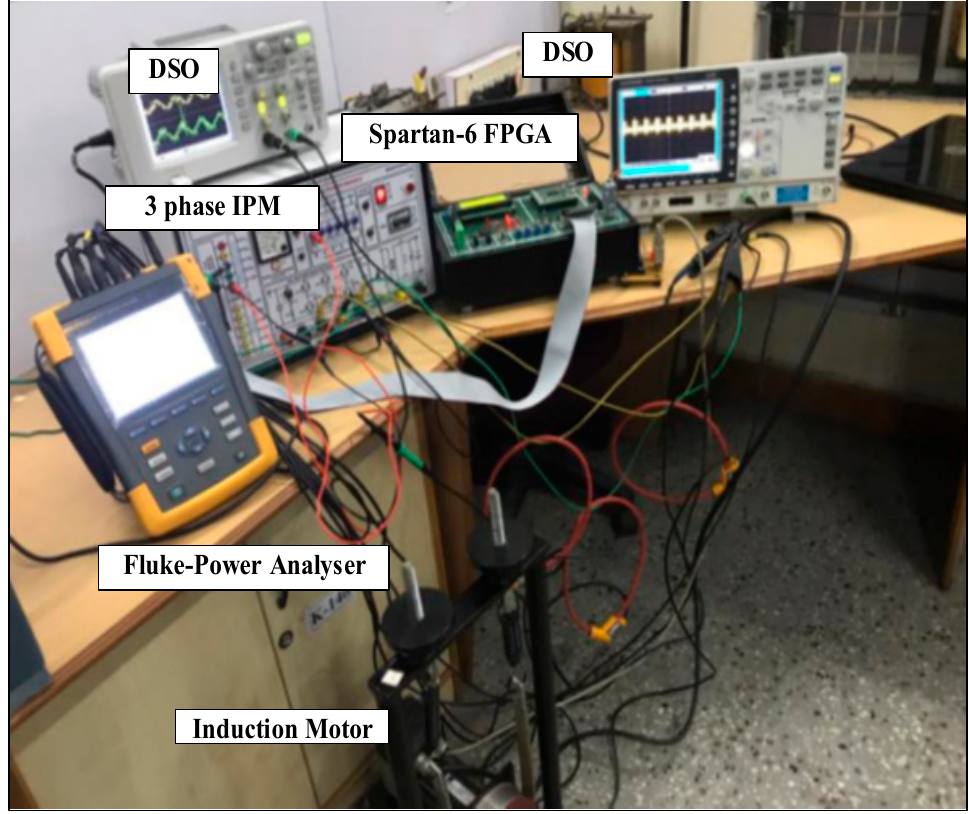
Figure 9. Laboratory ‐ scale experimental setup of three ‐ phase VSI ‐ connected induction motor drive.